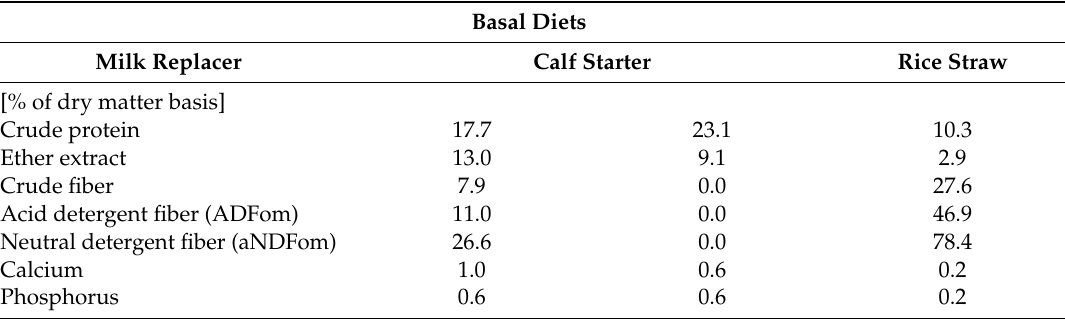
Table 1. Chemical compositions of basal diets used in this